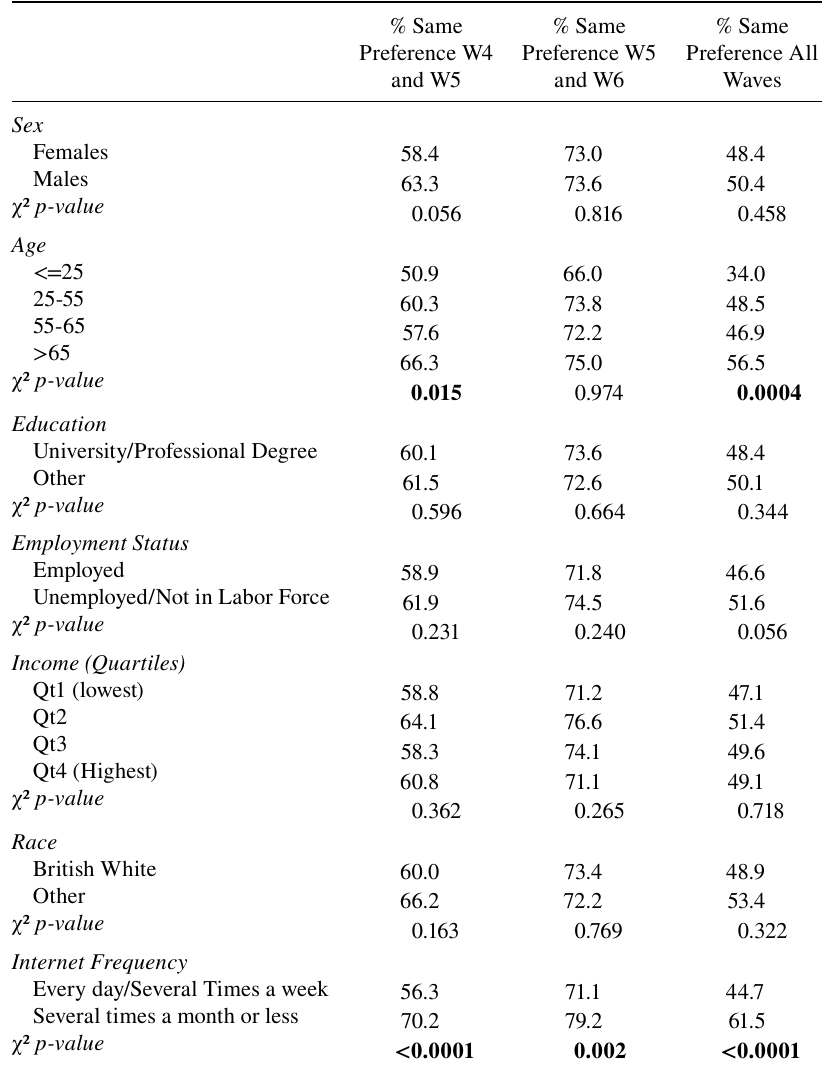
Table 7 Percent Reporting Same Preference Across Waves by Respondent